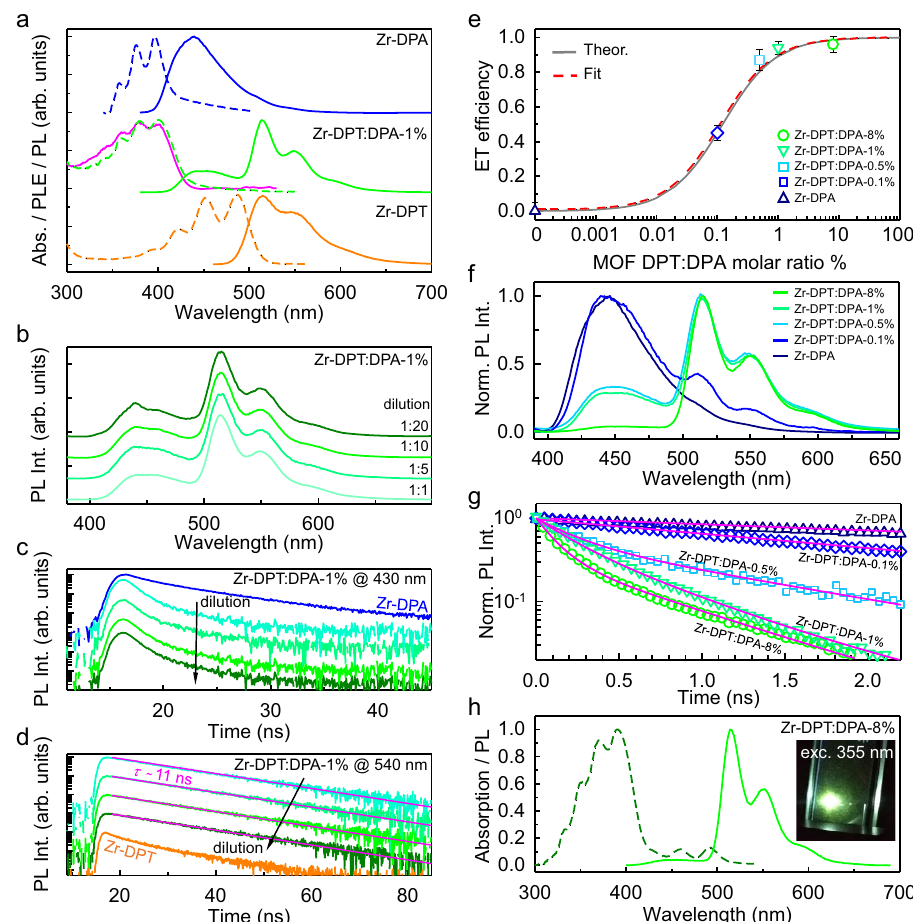
Fig. 3 Photophysical properties of hetero -ligand MOF nanocrystals. a Normalized absorption (dashed line) and photoluminescence (PL, solid line) spectra of the hetero -ligand Zr-DPT:DPA-1% nanocrystals (0.1 mg mL − 1 ) in tetrahydrofuran (THF) compared with homo -ligand MOFs based on DPA (Zr- DPA, 0.1 mg mL − 1 ) and DPT (Zr-DPT, 0.1 mg mL − 1 ). The excitation wavelength is 355 nm. The pink solid line is the excitation photoluminescence spectrum of the Zr-DPT:DPA-1% dispersion recorded at 540 nm. b PL spectrum of the Zr-DPT:DPA-1% dispersion at different dilution ratios under 355 laser excitation and c , d PL intensity decay with time recorded at 430 nm ( c ) and 540 nm ( d ) at the same dilution ratios of Zr-DPT:DPA-1% in comparison with that of Zr-DPA and Zr-DPT reference nanocrystals, respectively. e Energy transfer ef fi ciency ϕ ET between DPA and DPT co-ligands as a function of their relative molar ratio in the MOF framework. The theoretical ϕ ET (solid line) is calculated considering a diffusion-mediated Förster energy transfer with interaction radius of 2.8 nm derived from ligands properties. The fi t of experimental data (dashed line) results a characteristic interaction radius of 3.0 nm. Error bars show the standard deviation calculated for reported values. f Normalized PL spectra of the hetero -ligand nanocrystals dispersions series (0.1 mg mL − 1 ) and g time-resolved PL spectra recorded at 430 nm. Solid lines are the fi t of the data with multi-exponential decay function. h Absorption (dashed line) and PL (solid line) spectrum of Zr-DPT:DPA-8% nanocrystals in THF (0.1 mg mL − 1 , optical path 1 cm). The excitation wavelength is 355 nm. The inset is a digital picture of the dispersion in the quartz cuvette under 355 nm